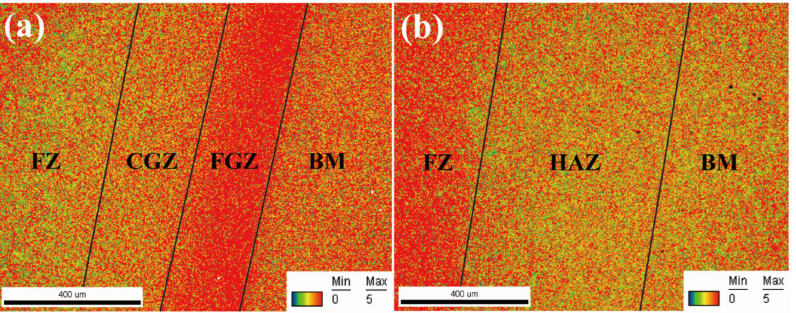
Figure 22. Distribution of kernel average misorientation: ( a ) before quenching; ( b ) after